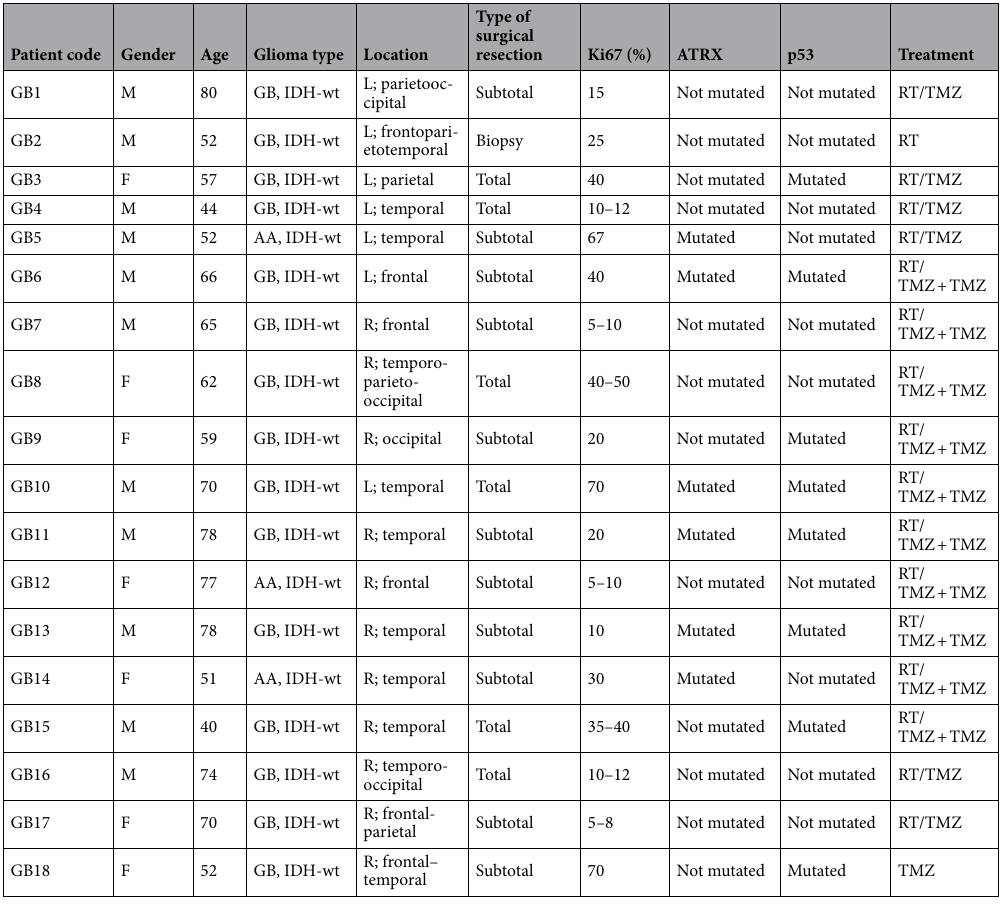
Table 1. Clinical and molecular information and chemotherapy regimen of malignant glioma patients. Clinical and molecular data of individual patients concerning age (at time point of surgery), gender (M = male; F = female), glioma type (AA = anaplastic astrocytoma; GB = glioblastoma; IDH = isocitrate dehydrogenase; wt = wild type), tumor localization (L = left hemisphere; R = right hemisphere), type of surgical resection, results of immunohistochemistry; percentage of cell proliferation marker Ki67, mutation or loss of ATRX and p53 expression, and treatment (RT = radiotherapy; TMZ = temozolomide) of